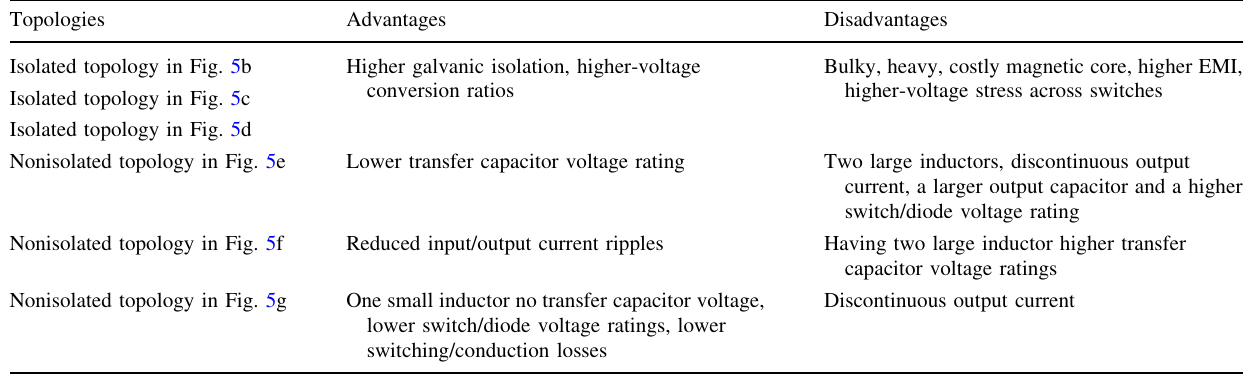
Table 5 Comparison of various topologies of the HESS [146] Topologies Advantages Isolated topology in Fig. 5b Isolated topology in Fig. 5c Isolated topology in Fig. 5d Nonisolated topology in Fig.